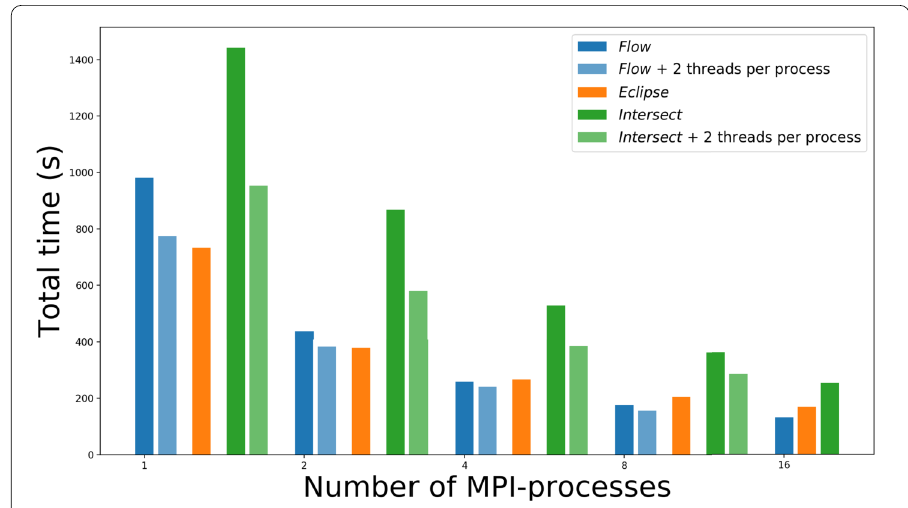
Figure 14 Execution time (in seconds) of Flow , Eclipse and Intersect on the Norne benchmark case. We include results for Flow and Intersect simulations where multithreading with two OpenMP threads per MPI-process is